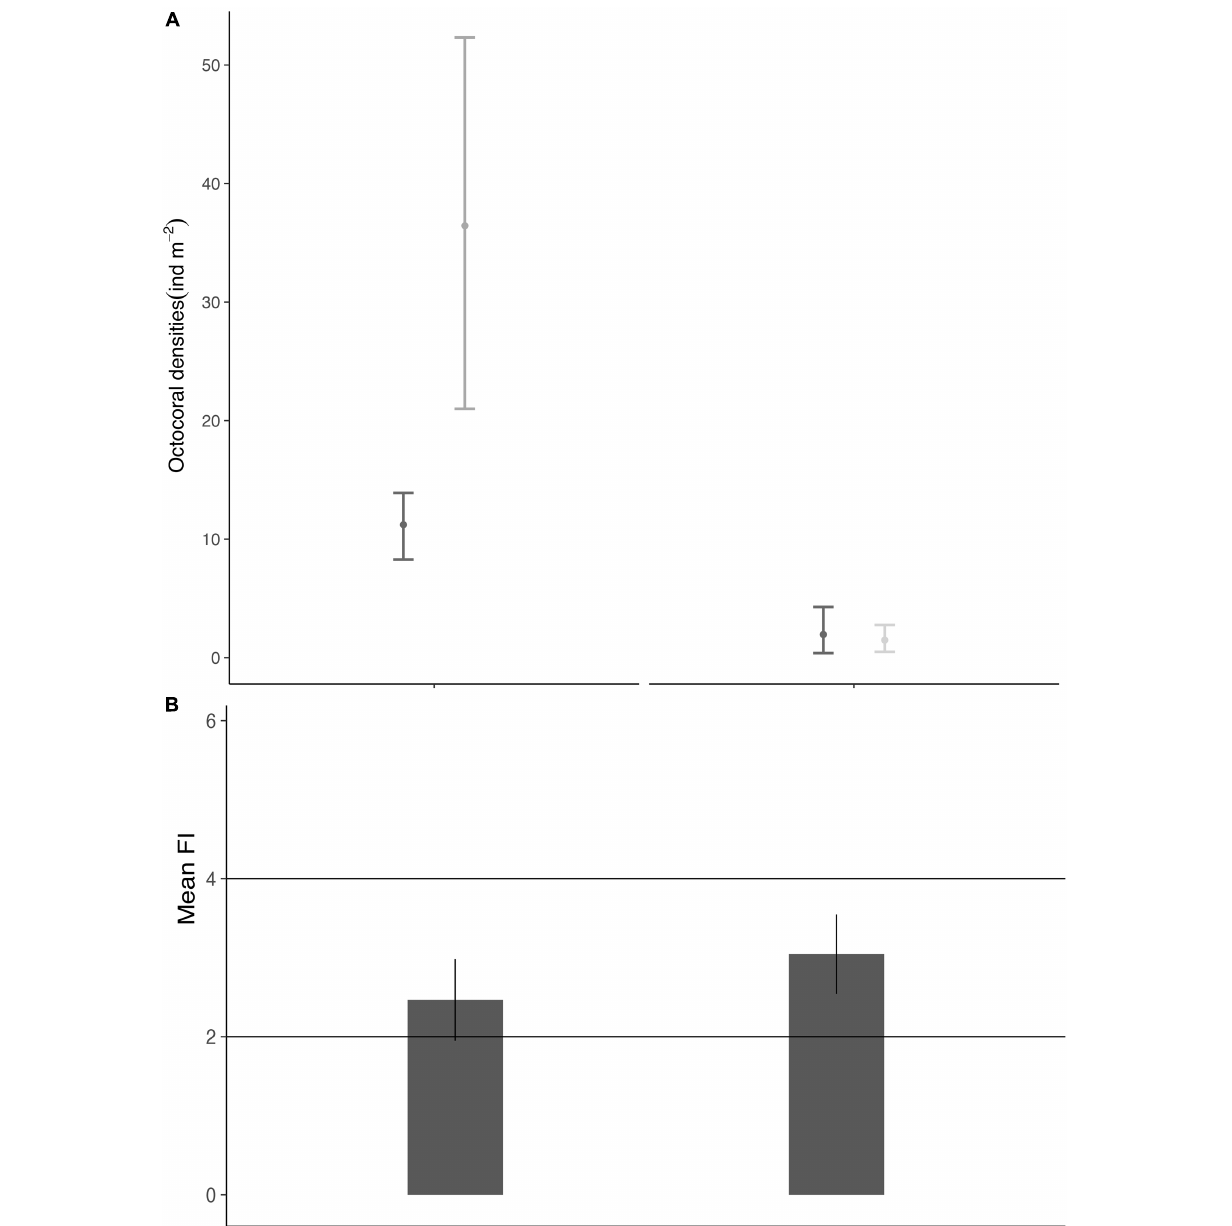
Frontiers in Marine Science |